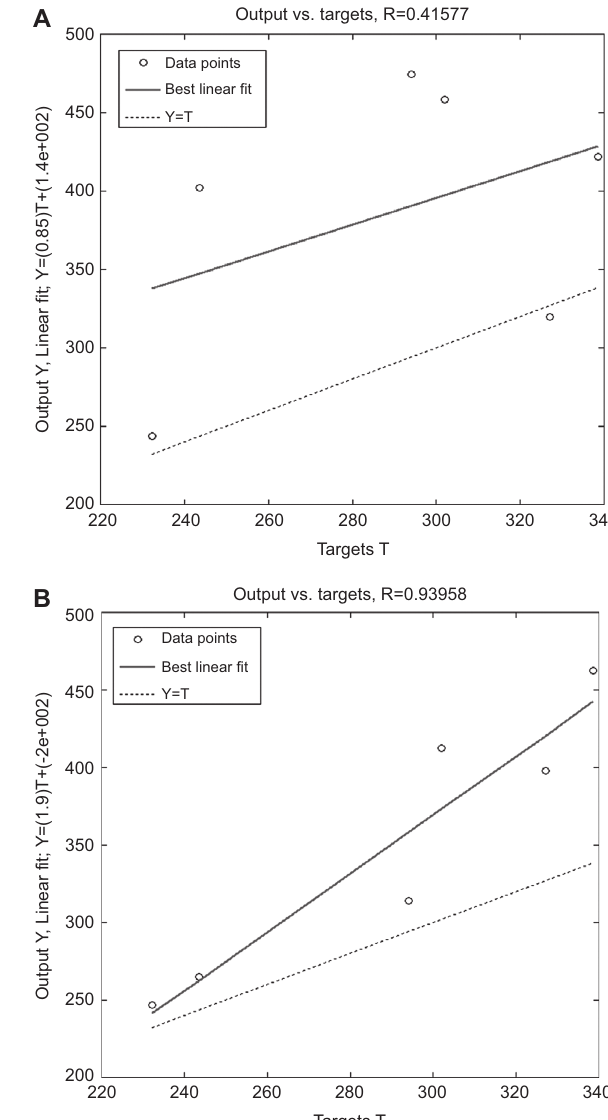
Figure 9 A parity plot among actual experiments and pre- nanofluid dicted values of the particle size response for the TiO 2 fluid obtained using the (A) RSM and (B) ANNs (the vertical and horizontal axes are predicted output and corresponding targets,